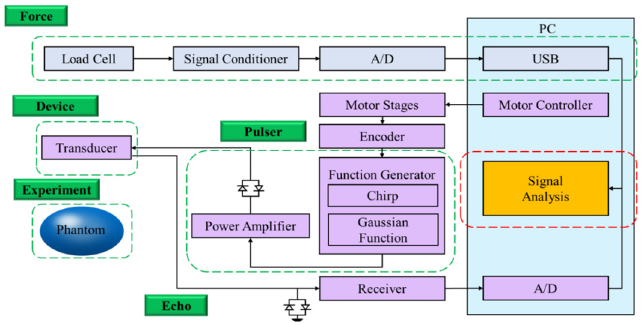
Figure 1. Block diagram of ultrasound elasticity imaging system.